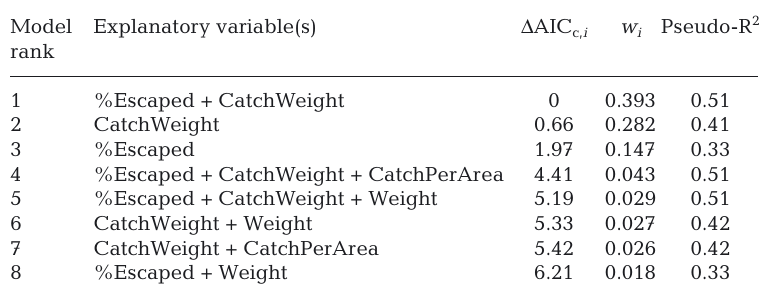
Table 1. Eight best models (out of 16 considered models), ranked by the Akaike’s Information Criterion corrected for small sample size (AIC c ) for explaining the per- centage of introgression in 20 rivers analyzed by Glover et al. (2013). Δ AIC c, i is AIC difference between model i and the best model and w i is the Akaike weight of model i . Akaike weights indicate the relative weight of evidence that a particular models is the best one; the remaining 8 models have a total Akaike weight of 0.03. Pseudo-R 2 describes the variability explained by the model. %Escaped =